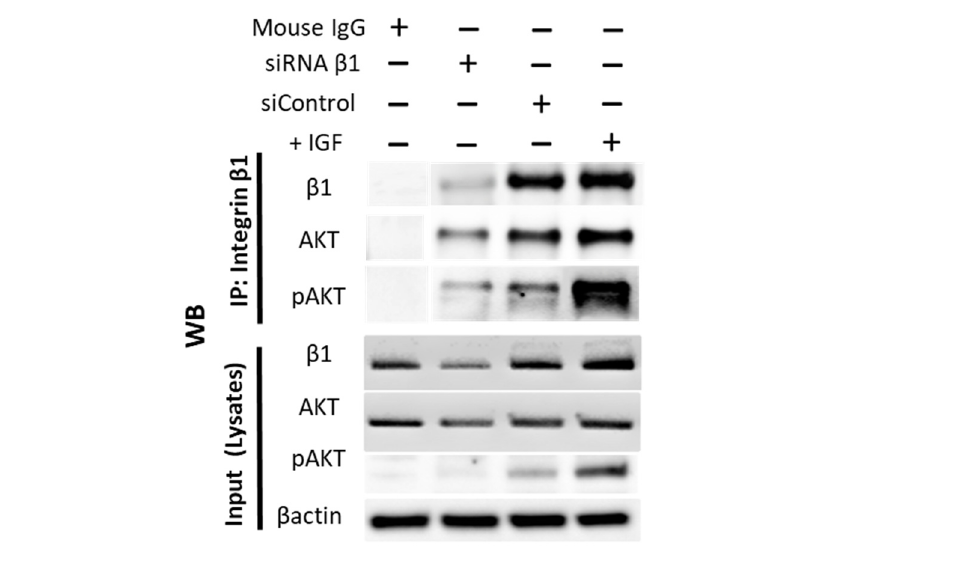
Figure 9. Integrin β 1 interacts with AKT. IP was performed wherein integrin β 1 was pulled down using mouse anti Human CD29 (Clone:18/CD29). Following SDS-PAGE electrophoresis and WB, the separated proteins were probed with antibodies against β 1, AKT, and pAKT. Lysate from cells treated with IGF1 (+IGF) demonstrated strong interaction of pAKT with integrin β 1. Lysate from cells treated with siRNA β 1 showed knockdown efficiency of β 1 protein. Mouse IgG was used as a negative con-trol. A total of 20 µg of cell lysate was used as input. IP, immunoprecipitation; WB, Western blotting.